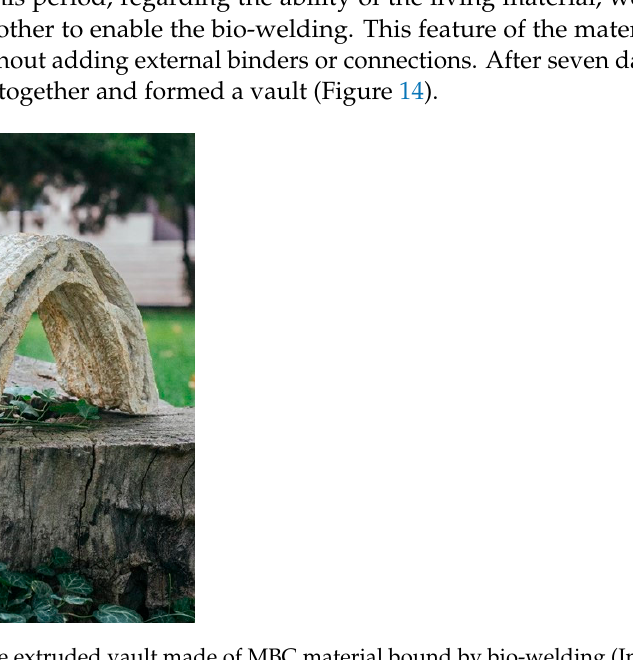
Figure 13. The printed arches growing in the chamber (Image credit: Authors).